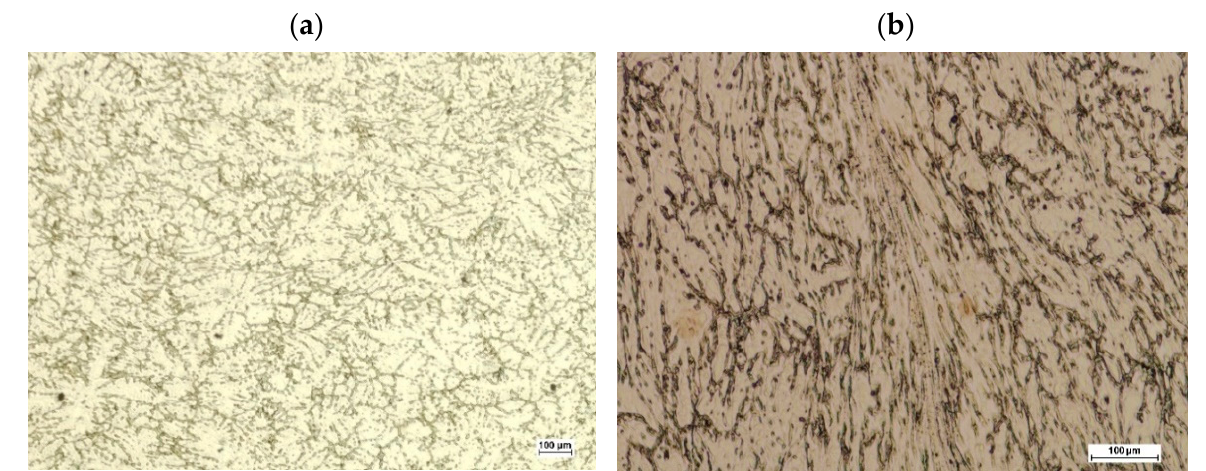
Figure 19. The disclosed microstructure of the sample with a square cross-section in the area of the axis after plastic deformation: ( a )—sample without axial discontinuity; ( b )—sample with artificially introduced axial discontinuity.